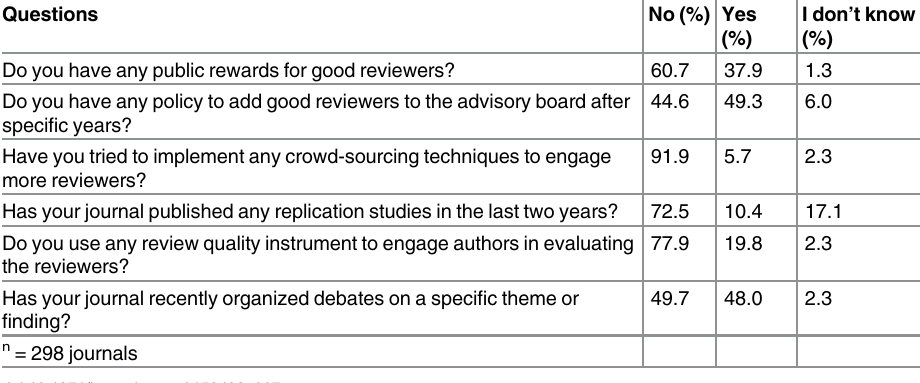
Table 7. Journal practices related to reviewers and the review